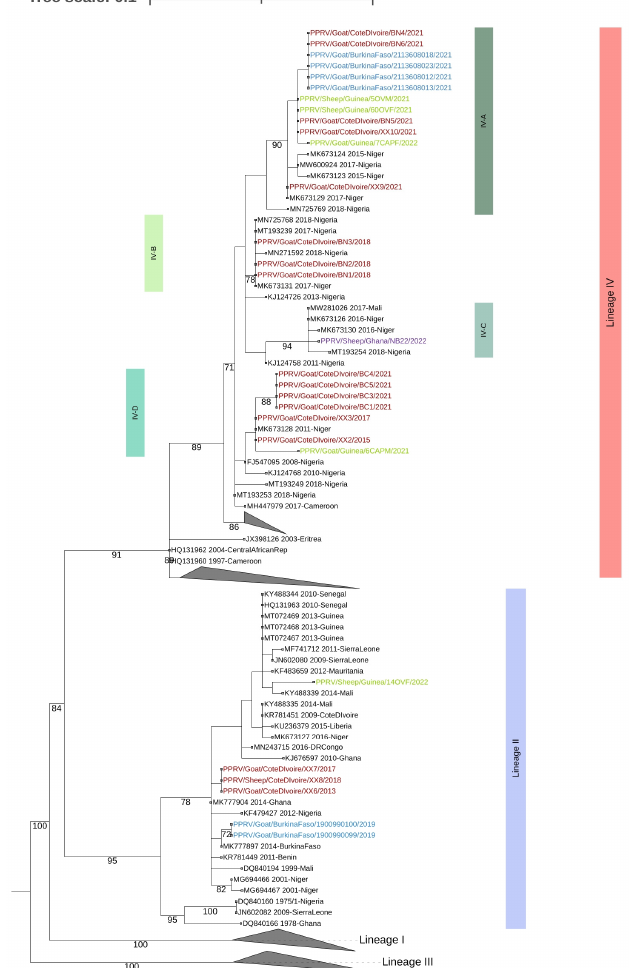
Figure 2. ML phylogenetic tree of the partial N gene sequences (219 nt) from the positive amplicons from this study combined with similar sequences available in GenBank. Sequences from Burkina Faso, Côte d’Ivoire, Ghana and Guinea are shown in blue, red, purple and green text, respectively. Lineages, subclades and bootstrap values >70% are indicated. Note: For image clarity some of the sequences/subclades in Lineage IV have been collapsed. An un-collapsed tree is available as Supplementary Figure S1.